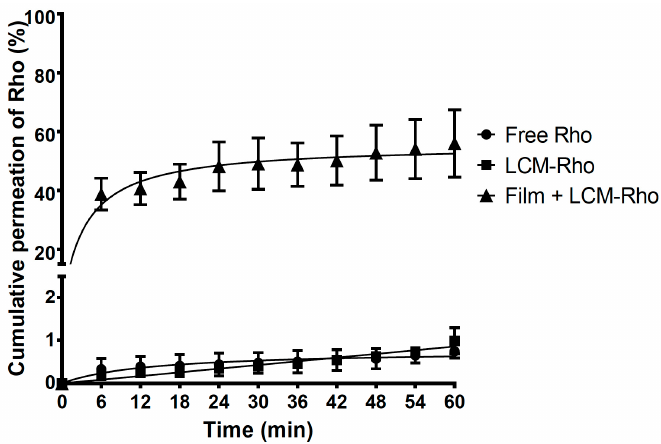
Figure 3. Cumulative ex vivo permeation profiles of rhodamine 123 (Rho) in solution, loaded in lipid-core micelles (LCMs) and in LCMs-loaded on mucoadhesive films through excised porcine buccal epithelium, with phosphate buffer pH 6.8. Values are represented as mean ± standard deviation of six different batches ( n = 6).